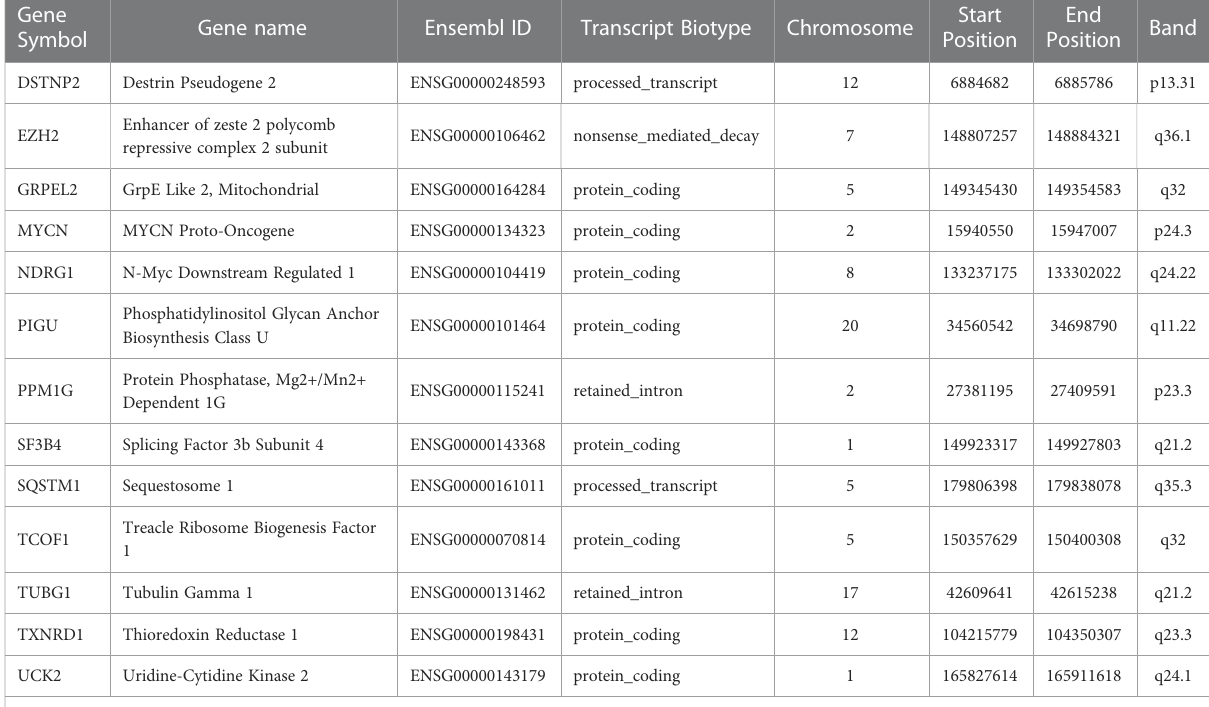
Obtained from National Center of Biotechnology Information (NCBI) database.